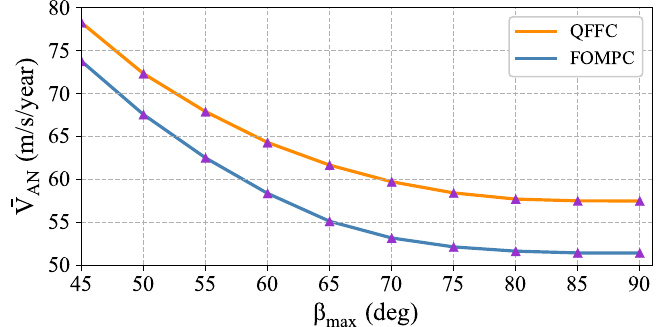
Figure 9. The results of Monte Carlo simulations for β max .